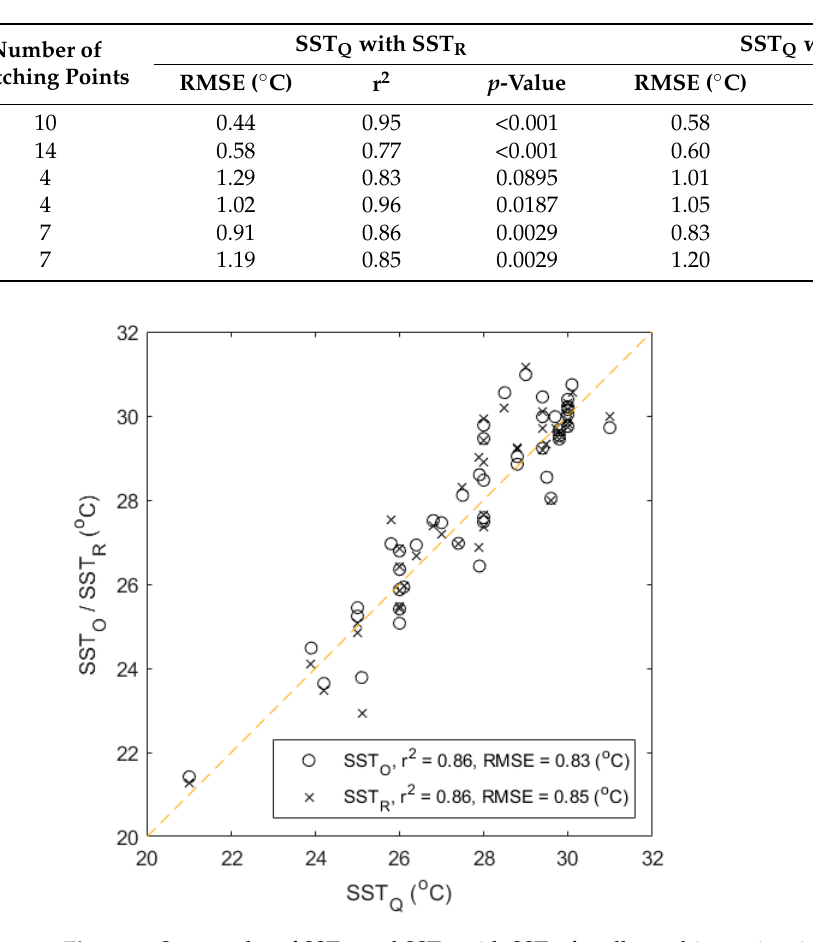
Figure 8. Scatter plot of SST O and SST R with SST Q for all matching points in six areas.